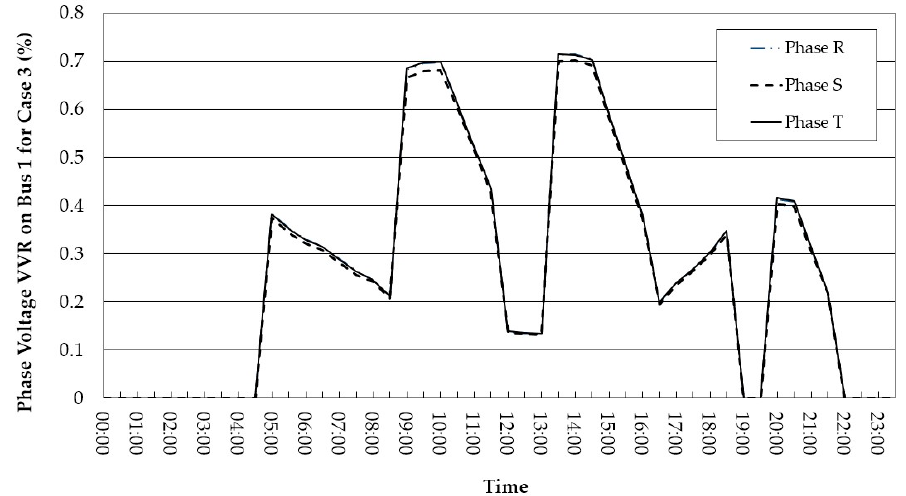
Figure 19. Three-phase VVR variation on Bus 22 for Case 2.